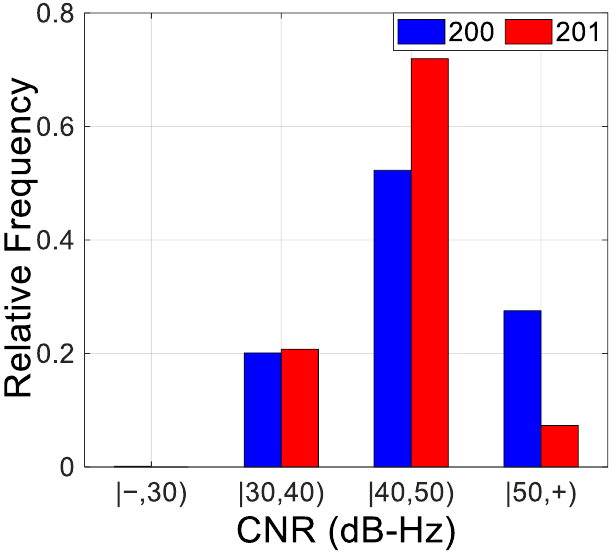
Figure 11. Histogram of the CNR and relative frequency. The blue and red bars denote the CNR collected on DOY:200 and DOY:201, 2021. | − ,30) means CNR lower than 30 dB-Hz. |50,+) means CNR larger than 50 dB-Hz. Symbol | and) denote inclusion and non-inclusion, respectively.